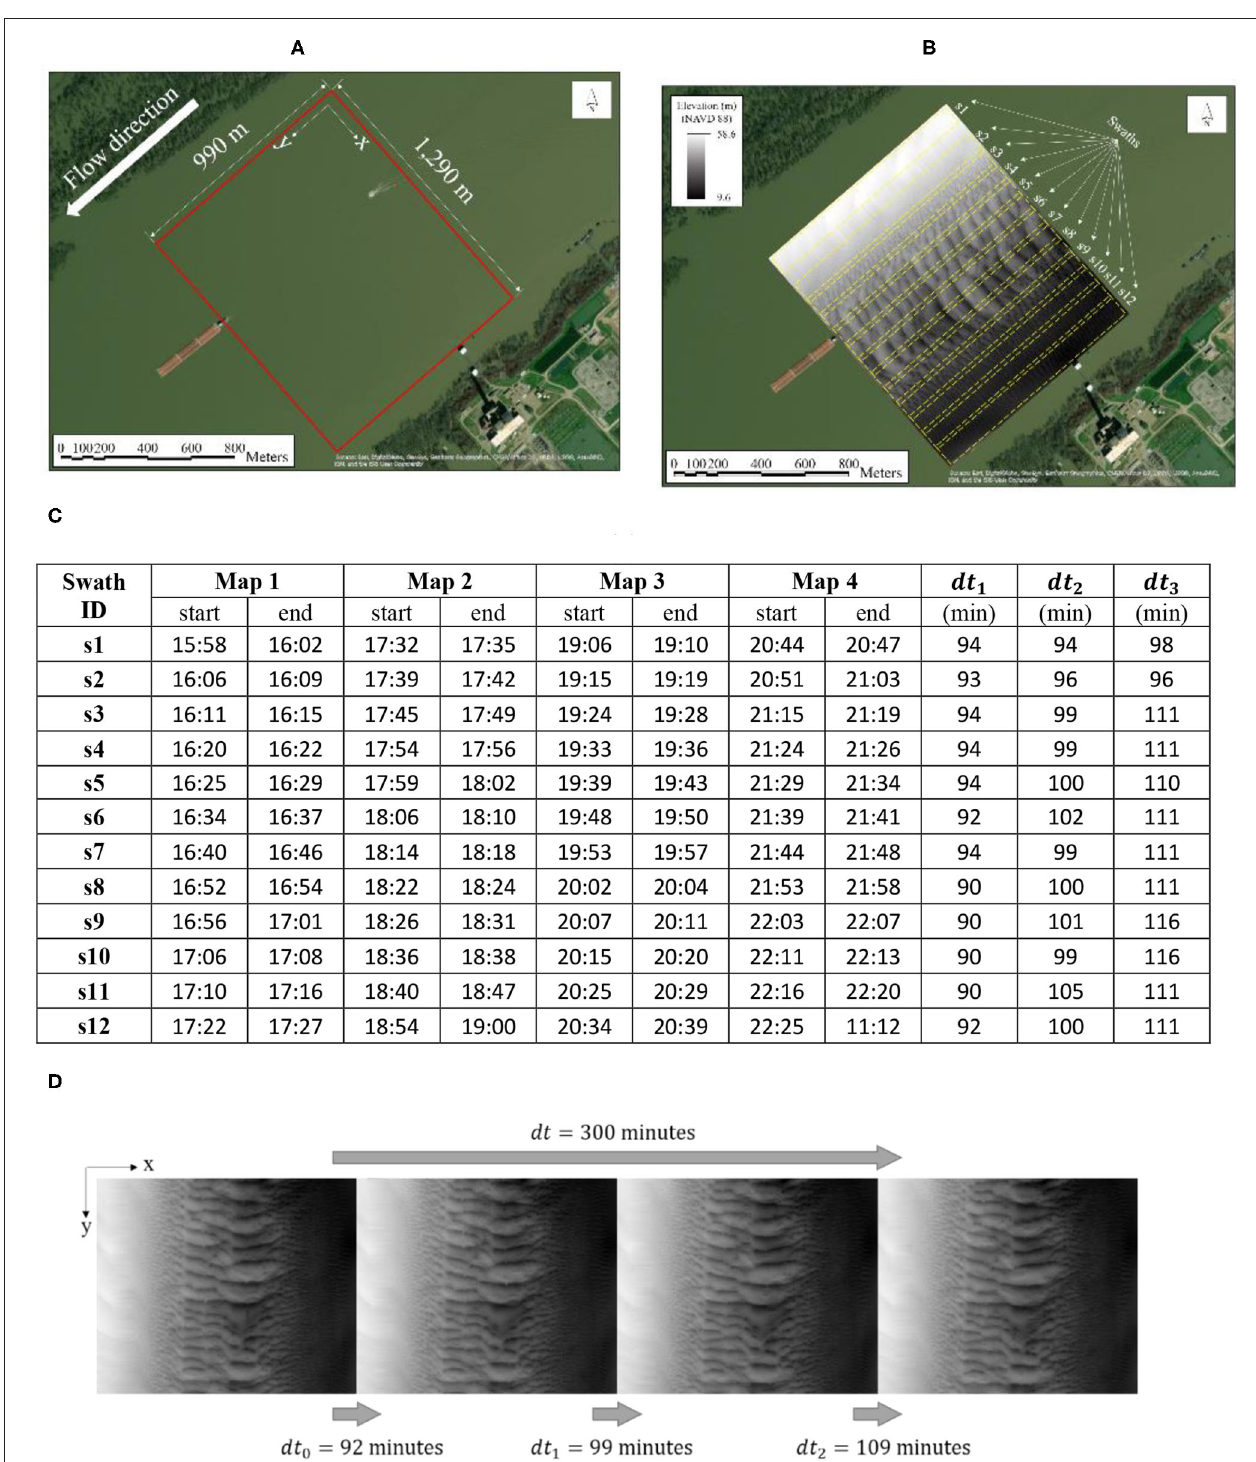
FIGURE 2 | Sequencing of data acquisition for assembling the acoustic maps: (A) aerial photo of the study site; (B) MBES data acquisition procedure; (C) timing of the individual swaths used to construct the acoustic maps; (D) acoustic maps assembled by stitching together the stream wise MBES swaths.